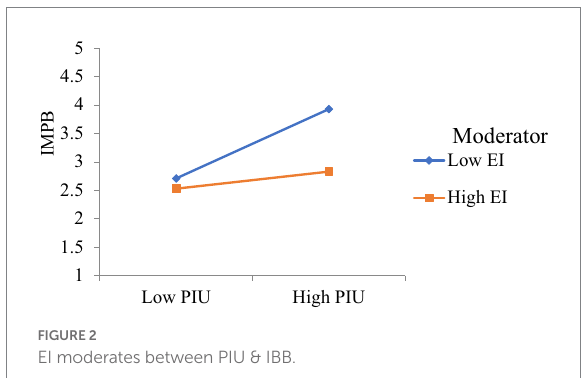
FIGURE 2 EI moderates between PIU &